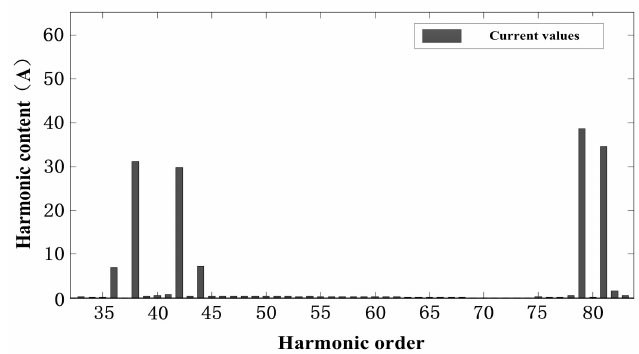
Figure 15. The high-order current harmonics near 40 and 80 times the fundamental